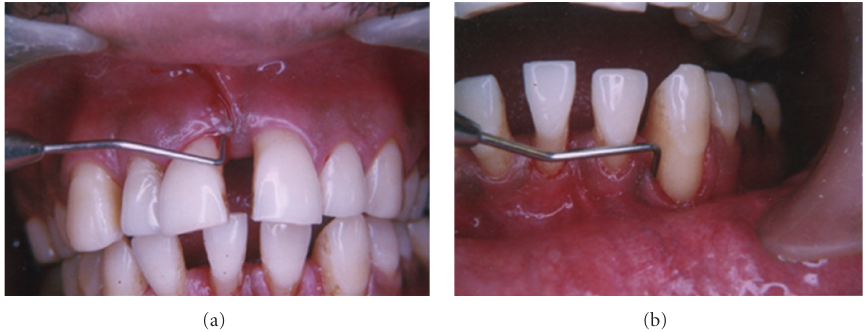
Figure 9: (a) and (b) Clinical presentation with deep pockets, recession, and pathologic migration of